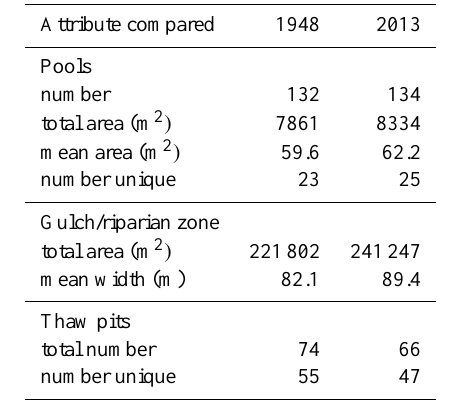
Table 2. Comparison of beaded stream morphology and ambi- ent thermokarst features between black and white photography ac- quired in 1948 and color infrared photography acquired in 2013 for a 2.7km segment of Crea Creek in the lower Fish Creek